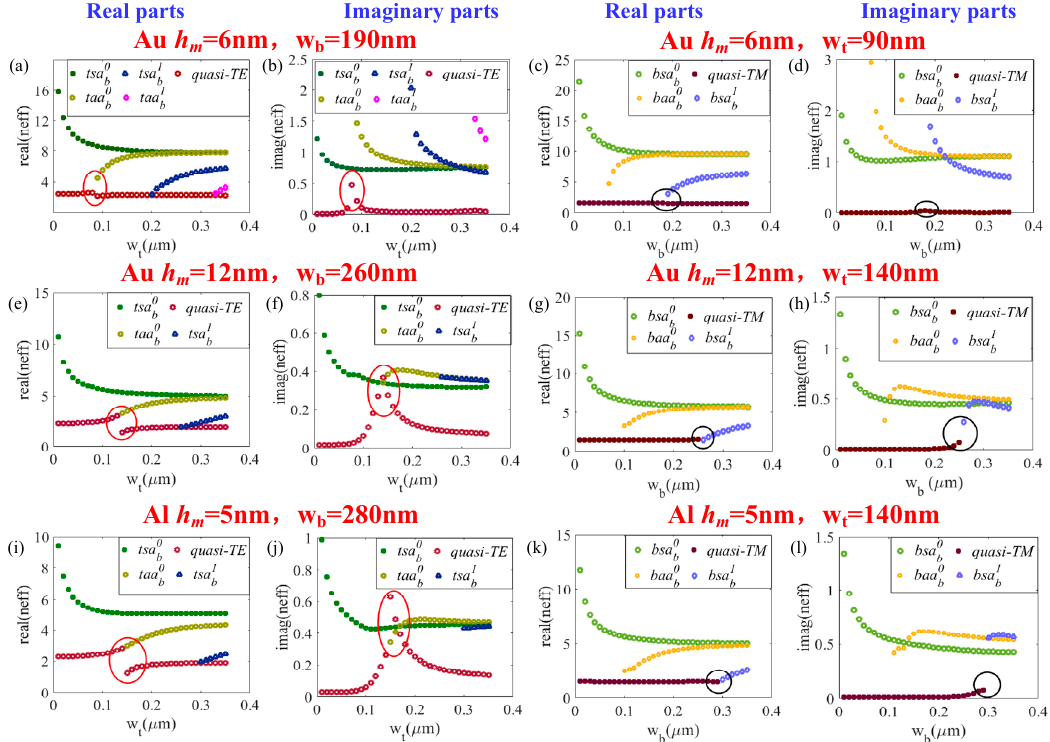
Figure 3. ( a , c , e , g , i , k ) Real parts and ( b , d , f , h , j , l ) imaginary parts of the mode effective indices: ( a , b ) versus w t , w b = 190 nm, Au, hm = 6 nm; ( c , d ) versus w b , w t = 90 nm, Au, hm = 6 nm; ( e , f ) versus w t , w b = 260 nm, Au, hm = 12 nm; ( g , h ) versus w b , w t = 140 nm, Au, hm = 12 nm; ( i , j ) versus w t , w b = 280 nm, Al, h m = 5 nm; ( k , l ) versus w b , w t = 140 nm, Al, hm = 5 nm. Other parameters: λ = 1.55 µm, w si = 600 nm, h si = 220 nm.